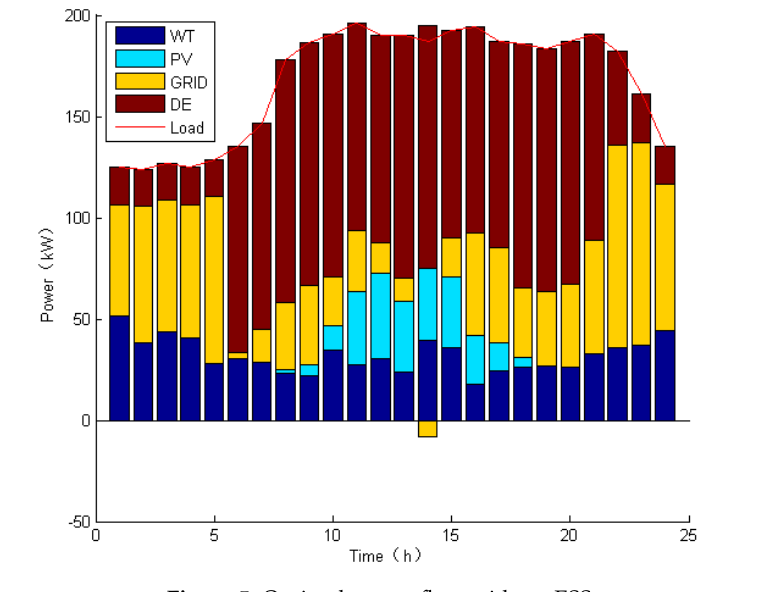
Figure 5. Optimal power flow without